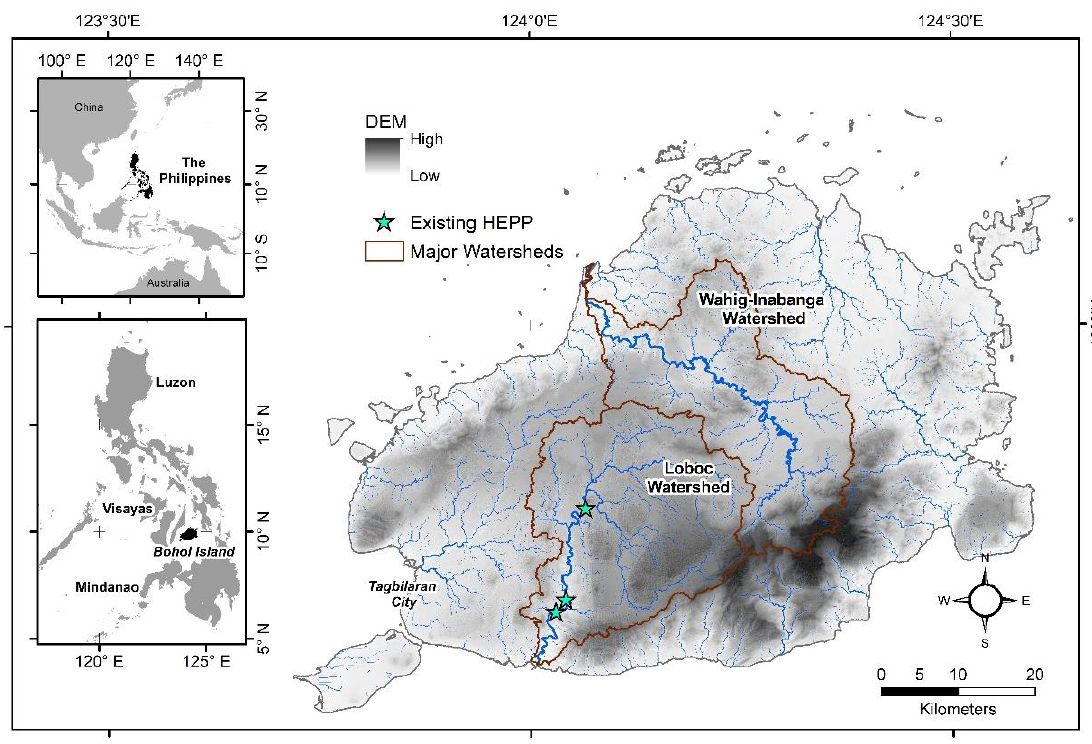
Figure 6. The Bohol Island, its drainage network, the three existing hydropower plants, and the major watersheds.